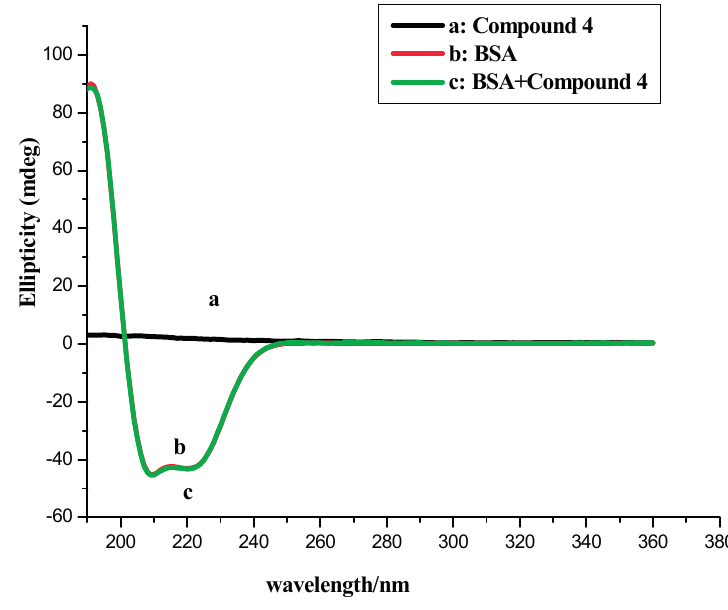
Figure 11. CD spectra of BSA in the presence of the compounds. Conditions: c (BSA): 40.0 × 10 –6 mol·L –1 ; c (conpounds): 0, 120.0 × 10 –6 mol·L –1 .